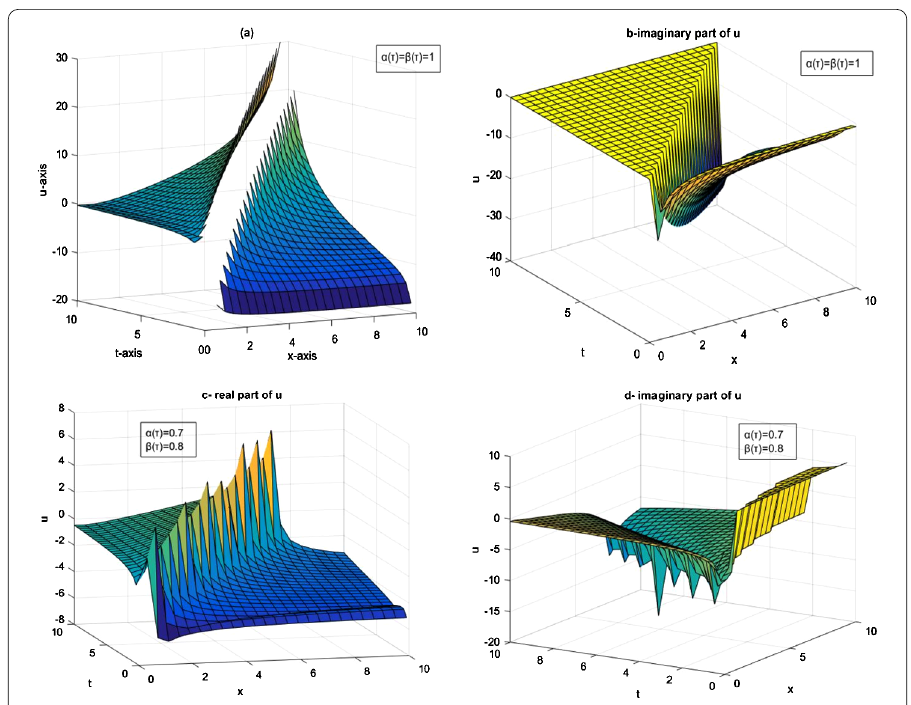
Figure 5 ( a ) and ( b ) are the graphs of the real and the imaginary parts of the solution u in Example 3, where α ( τ ) = β ( τ ) = 1. ( c ) and ( d ) are the graphs of the real and the imaginary parts of u , where α ( τ ) = 0.7 and β ( τ ) =